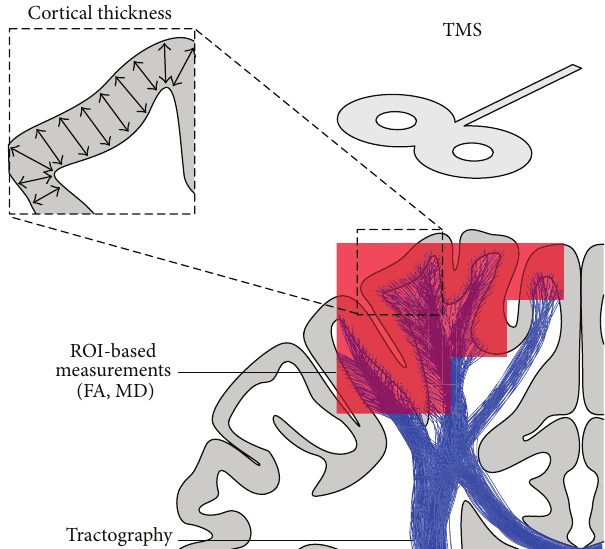
Figure 4: Utilising fMRI in conjunction with a number of other modalities. The red region indicates an area of significant activation, determined with fMRI. When combined with structural MRI, these activated regions can be used as ROIs in which targeted measures of cortical thickness can be made. When combined with diffusion MRI, the fMRI ROIs can be used as sample regions for FA and MD values within subcortical white matter, both of which provide information about tissue microstructure. These ROIs can also act as seed regions to drive tractography, from which white matter connectivity and integrity can be measured. Combining fMRI with TMS measures can also provide context to and certainty about the functional-relevance of fMRI-based findings. ROI: region of interest; FA: fractional anisotropy; MD: mean diffusivity; TMS: transcranial magnetic